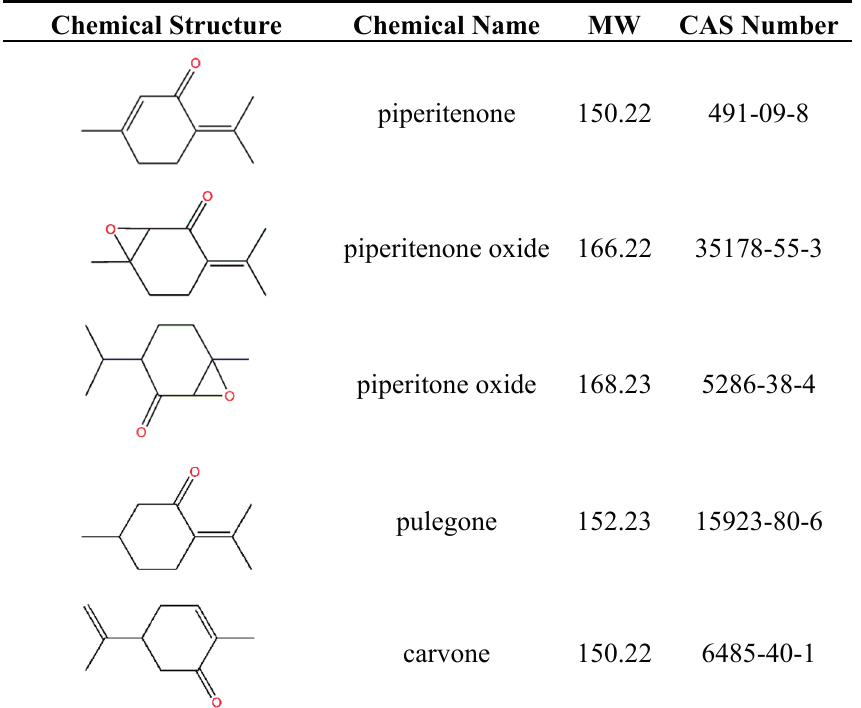
Table 1. Chemical structures, names, MWs and CAS numbers of some of the most common constituents in